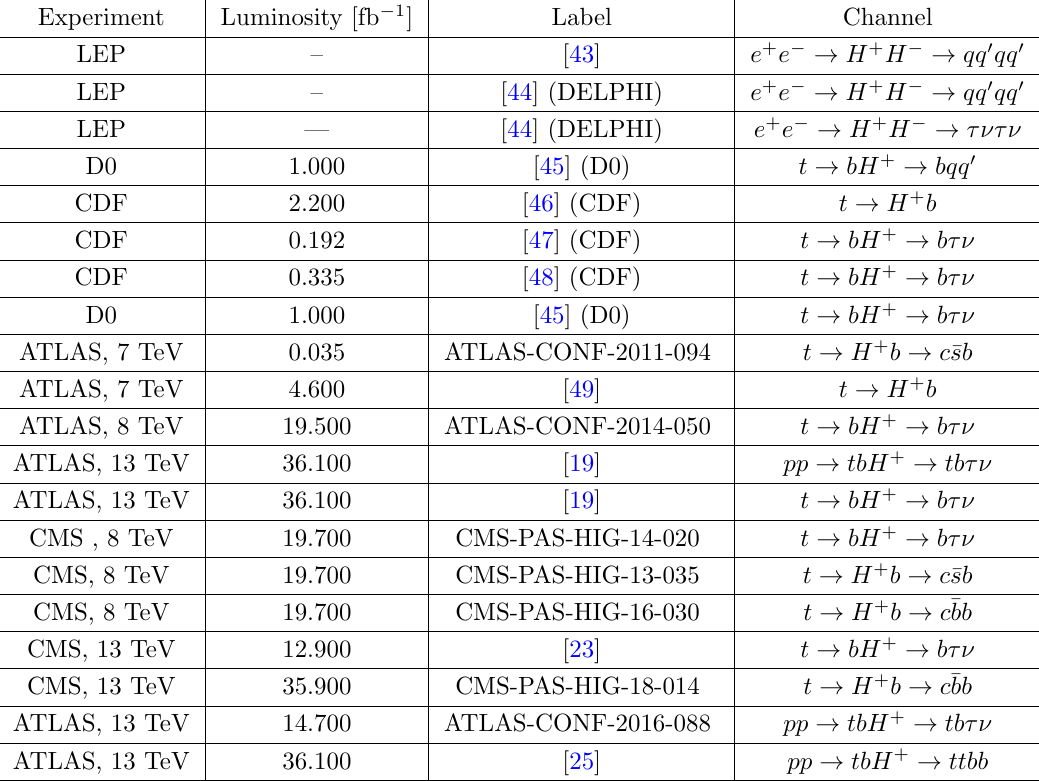
Table 1 . Constraints on charged Higgs boson processes implemented in HiggsBounds and used in our